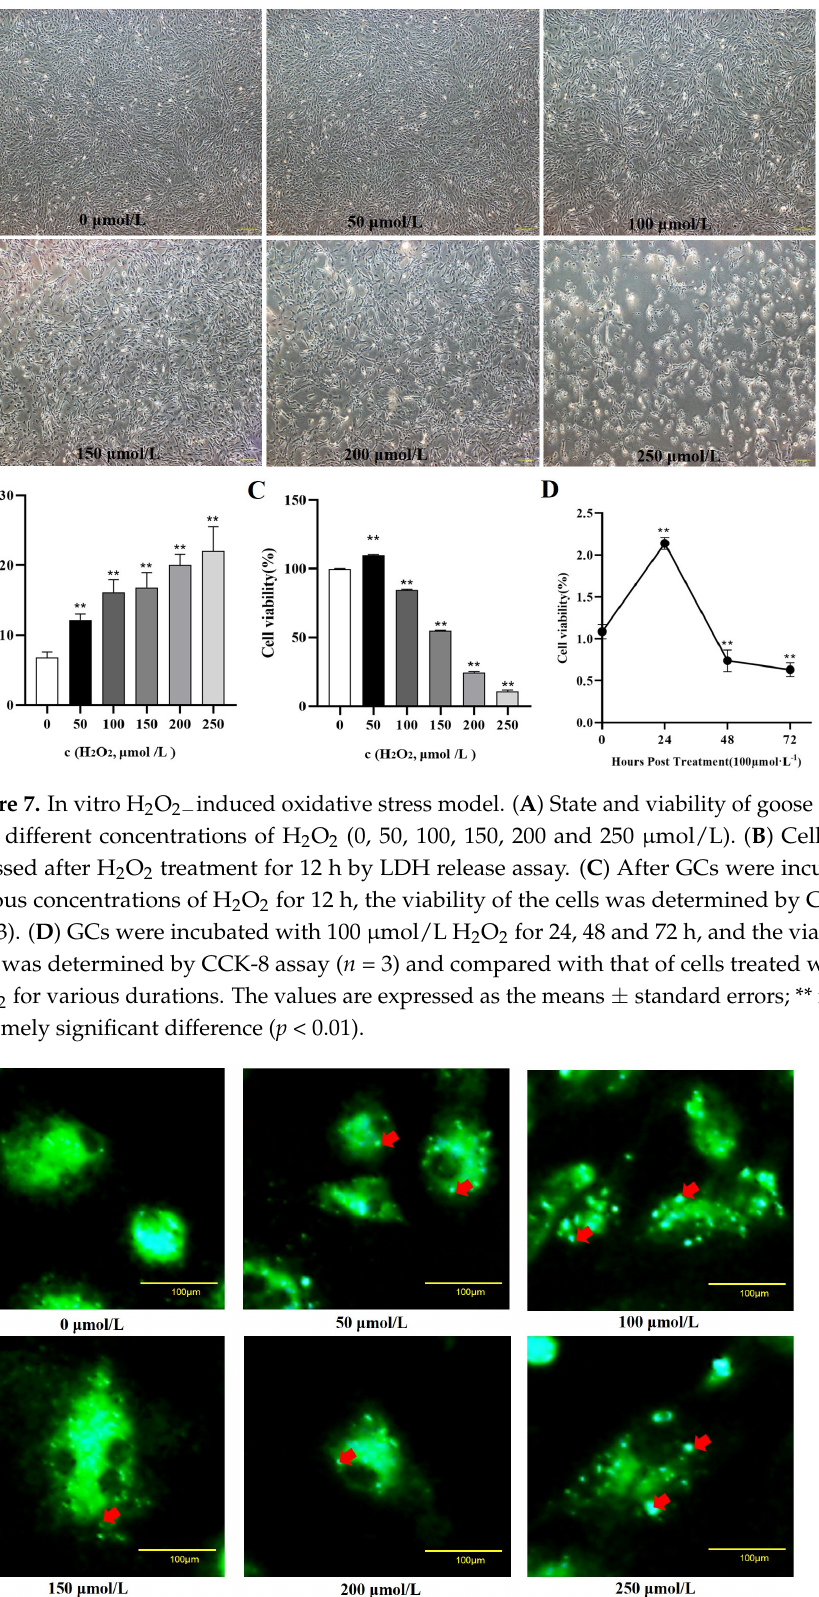
Figure 8. Fluorescence microscopy of MDC staining. GCs transfected with an MDC plasmid were incubated with 100 µ M H 2 O 2 for 12 h. Red arrow: Laser confocal scanning microscopy was used to observe the fluorescent autolysosomes puncta in GCs. Scale bar = 100 µ